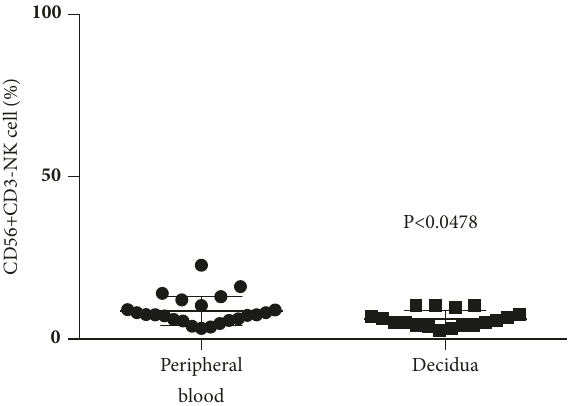
Figure 1: Percentage of CD56+CD3- cells among lymphocytes at term pregnancy in peripheral blood and decidua. The percentages of CD56+CD3- lymphocytes in decidual cells were lower than those in peripheral blood.